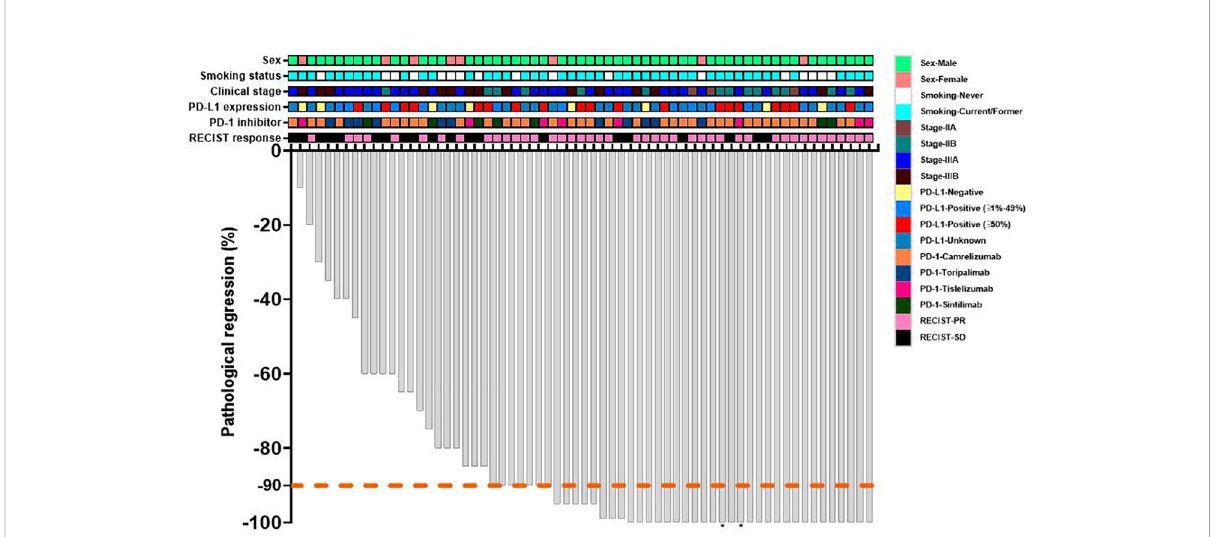
FIGURE 2 Waterfall plot of pathological response of neoadjuvant therapy. Each bar represents one patient. The upper rows show clinical characteristics and radiological responses. PD-L1, programmed death-ligand 1; PD-1, programmed death 1; RECIST, response evaluation criteria in solid tumors; PR, partial response; SD, stable disease. *The regional lymph node of dissection involvement persisted.